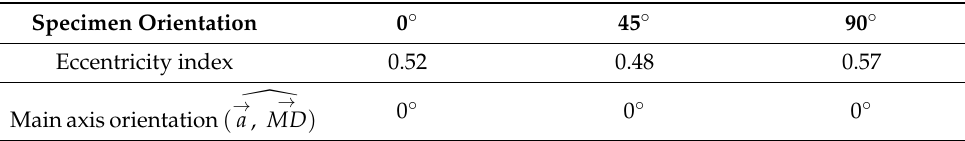
Figure 9. Initial state ( I ) and preformed nonwoven specimens at 0°, 45°, and 90° angles for nonwoven material MD-axis relative to the machine x -axis ( a – c , respectively). Red bold arrows indicate the maximum draw-in. Table 2. Characteristics of the deformed ellipse on preformed